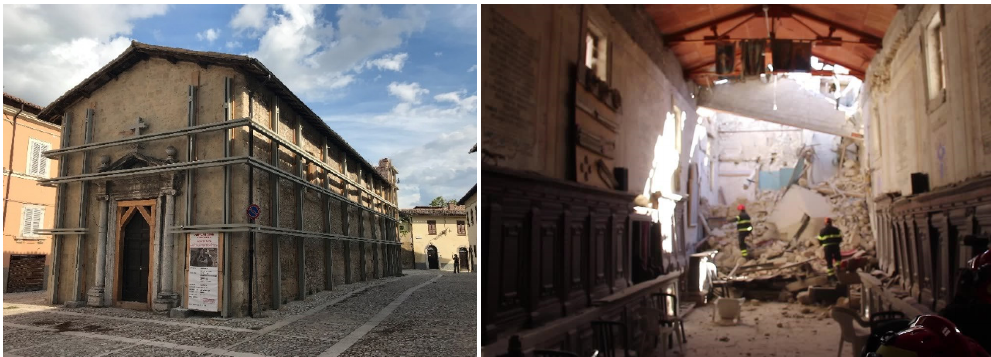
Figure 2. The Church of San Lorenzo in Norcia after the damage of the earthquake.